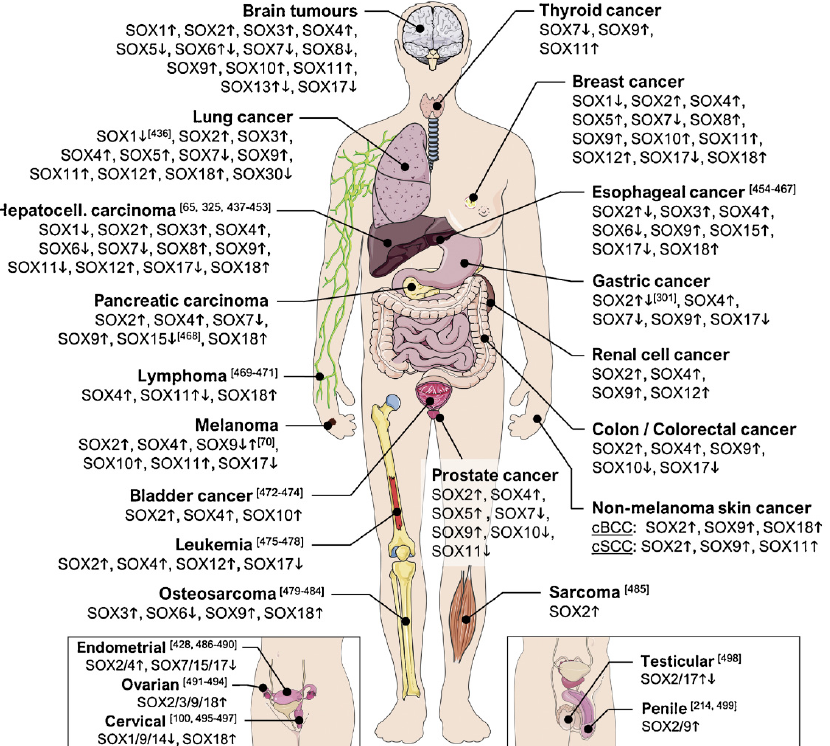
Figure 4. The involvement of SOX protein subfamiles in human cancers. SOX genes can be upregulated or downregulated in tumor cells including skin cancer, bone cancer, brain cancers, respiratory cancers, gastrointestinal cancers, leukemia, urological cancers, gynecologic cancers, and breast cancer. Reprinted by permission from Elsevier, Seminars in Cancer Biology [46], Copyright 2020.